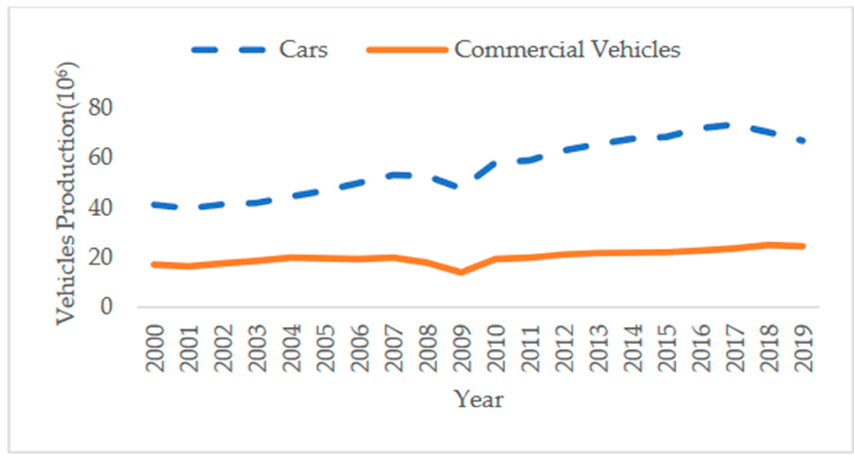
Figure 1. The vehicles production between 2000 and 2019.